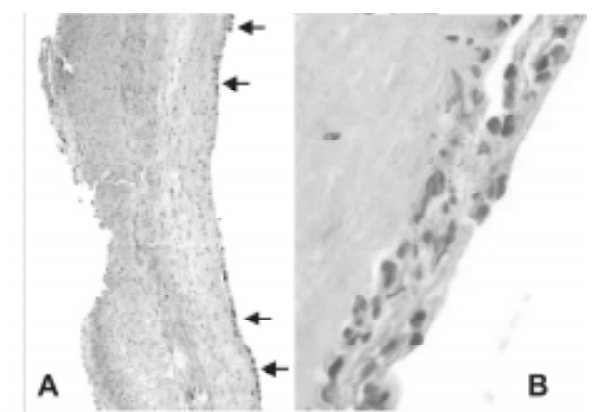
Figure 3. A. Microphotography of the coronary arterial wall. Moderate to intense inflammatory reaction with neutrophilic infiltration in the endothelial layer (arrows). Also thickening of the arterial walls and edema of the mid-tunic can be observed. (hematoxylin-eosin; 40X magnification). B. The same specimen magnified by 400X, highlighting the neutrophils infiltrating the endothelium, suggesting an acute reaction.